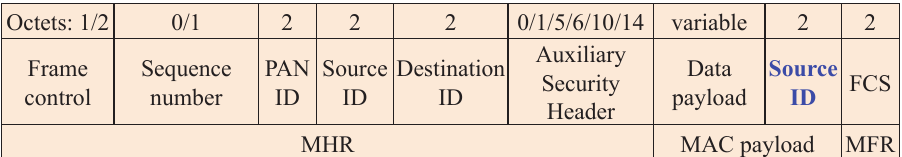
Figure 5. The proposed data frame